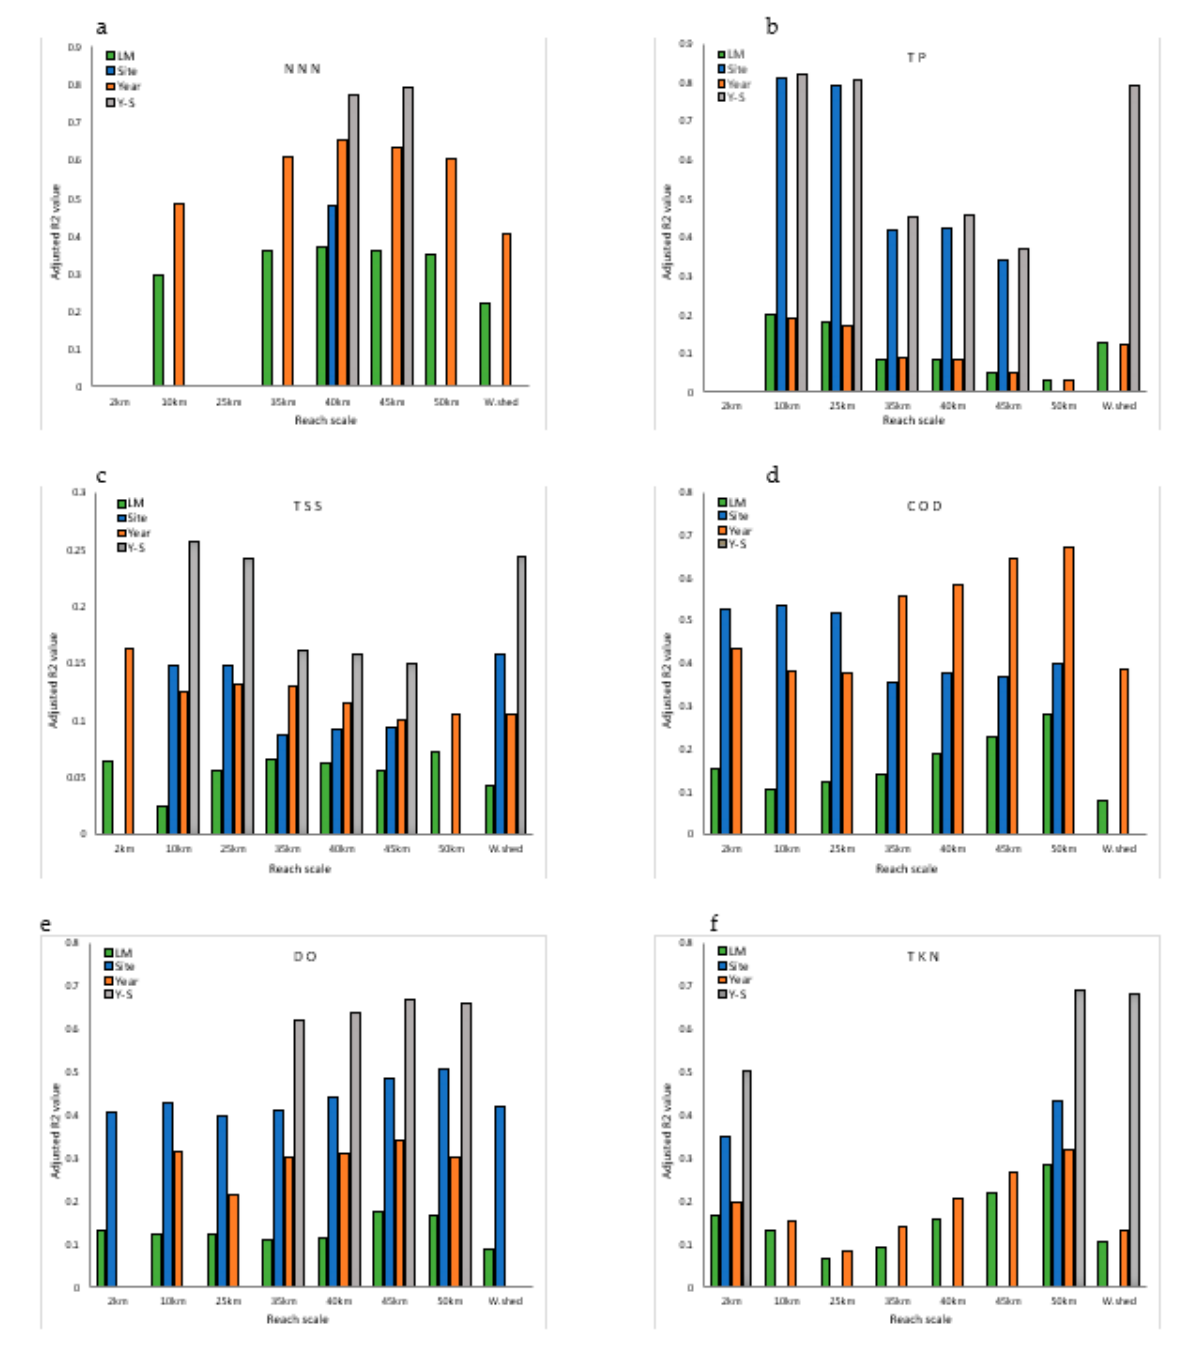
Figure 5. The adjusted R 2 of multiple regression models describing the strong associations between land use and water quality across spatial scales and different models ( a ) NNN, ( b ) TP, ( c ) TSS, ( d ) COD, ( e ) DO, and ( f ) TKN.